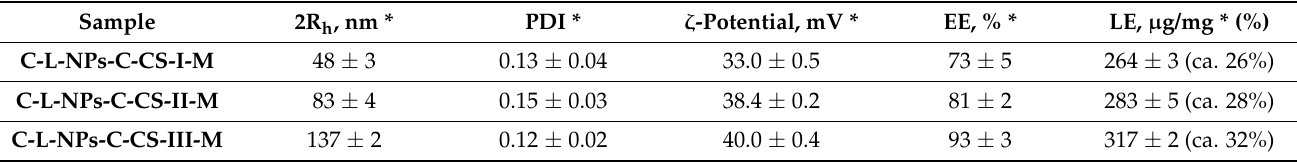
Table 7. Characteristics of loaded self-assembled nanoparticles (Scheme 1, system